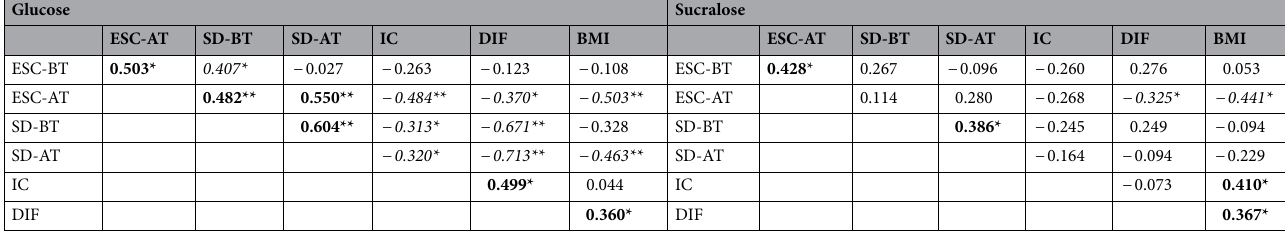
Table 1. Zero order correlations between the interoceptive indices, alexithymia, and BMI in the glucose and sucralose conditions. N = 62. IC interoceptive coherence (this measure was reversed so that a higher score indicated that as blood glucose levels increased hunger decreased), SD satiety divergence (a higher score indicated a lower divergence between the participants pre-prandial and post-prandial satiety − a higher score means individuals would be driven primarily by their expectations), ESC expected satiety confidence, BT before tasting, AT after tasting, DIF difficulty identifying feelings, BMI body mass index. Bold—significant positive correlation, Italic—significant negative correlation. *p < 0.05, **p < 0.001.